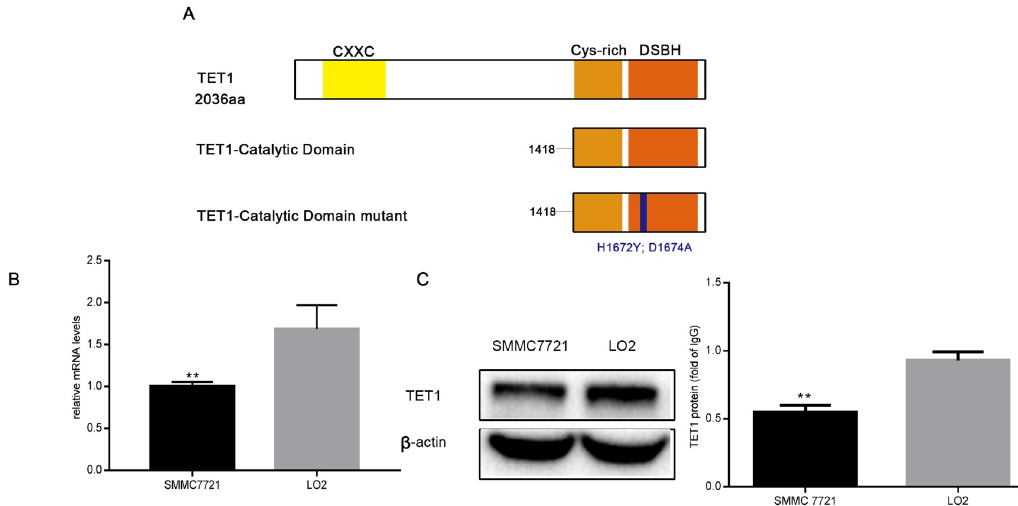
Fig 1. The expression of TET1 is downregulated in the SMMC 7721 cells. (A). Structure of TET1 protein. TET1 protein contains a CXXC domain and a catalytic domain (CD) including a Cys-rich part and a DSBH part. TET1-mCD (TET1-CD mutant) harbours two mutated amino acid in the DSBH part of the CD. (B). Expression of TET1 mRNA in the SMMC 7721 cells and LO2 cells was analyzed by Quantitative RT-PCR, and the results were represented as mean ± SD of three independent experiments. �� p < 0.01. (t-test). (C). Western blot was used to analyze the expression of TET1 protein in the SMMC 7721 cells and LO2 cells. β -actin was used as an internal control.